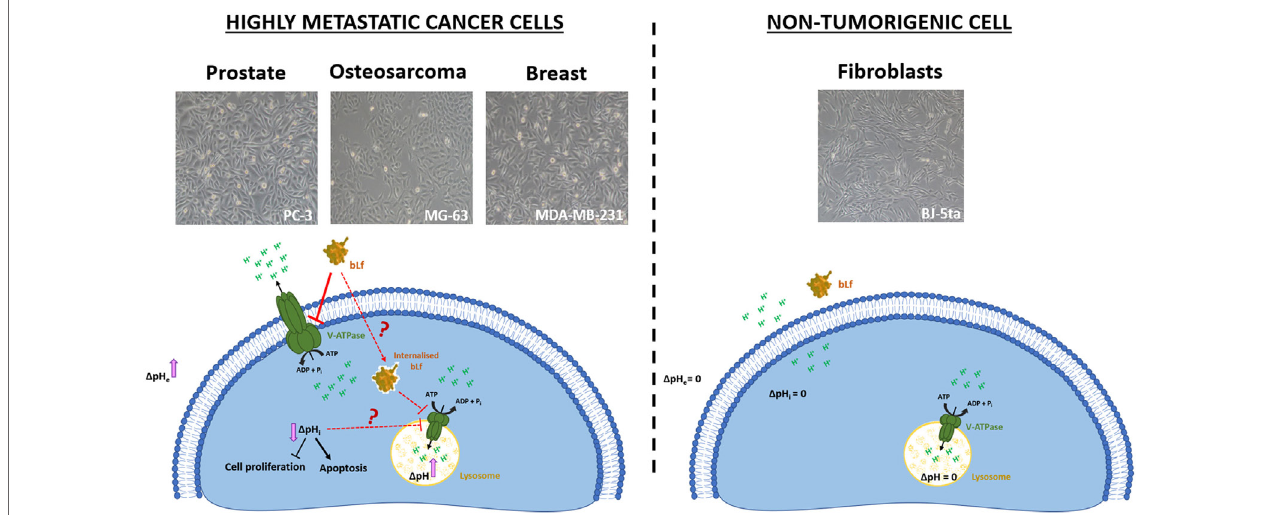
FigUre 7 | Working model for the molecular mechanism underlying the anticancer activity of bovine lactoferrin (bLf). The exposure of highly metastatic cancer cells to bLf leads to the inhibition of plasmalemmal V-ATPase proton pumping activity and subsequent extracellular alkalization, intracellular acidification, inhibition of cell proliferation, and induction of apoptosis. The observed lysosomal dysfunction is possibly due to lysosomal V-ATPase inhibition. By contrast, the non-tumorigenic cells, which do not have plasmalemmal V-ATPase and express lower levels of this protein, are resistant to